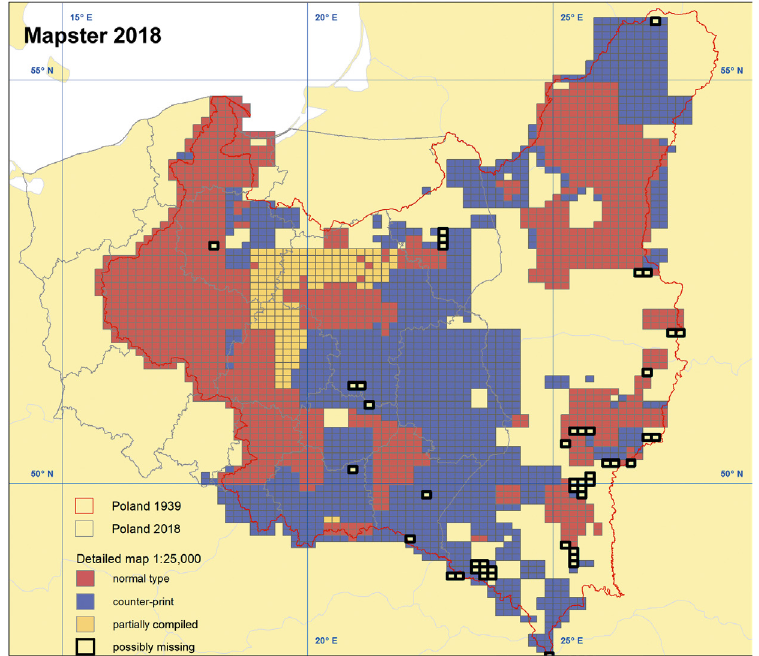
Fig. 5. MGI’s 1:25,000 detailed map, various types of sheets available at Mapster, highlighted sheets are possibly missing (confirmed by at least one source) (Author’s original